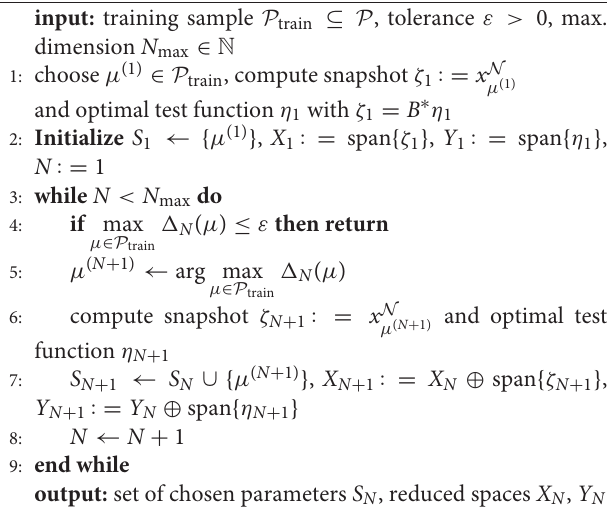
and optimal test function η 1 with ζ 1 = B ∗ η